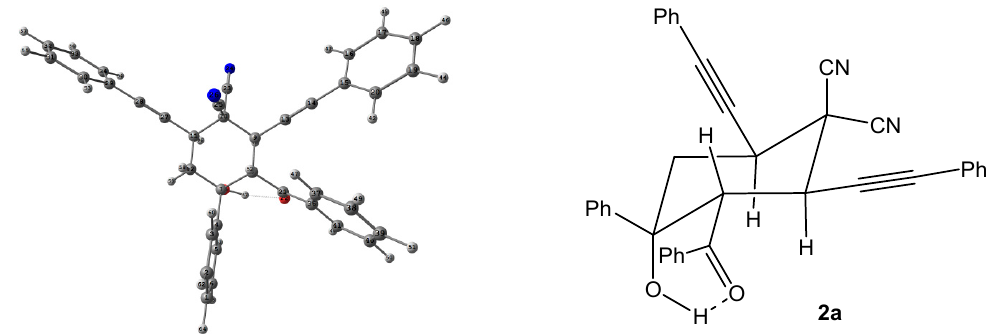
Figure 3. DFT-calculated the most stable isomer 2a (on the left ) and its chair-conformer structure (on the right ).